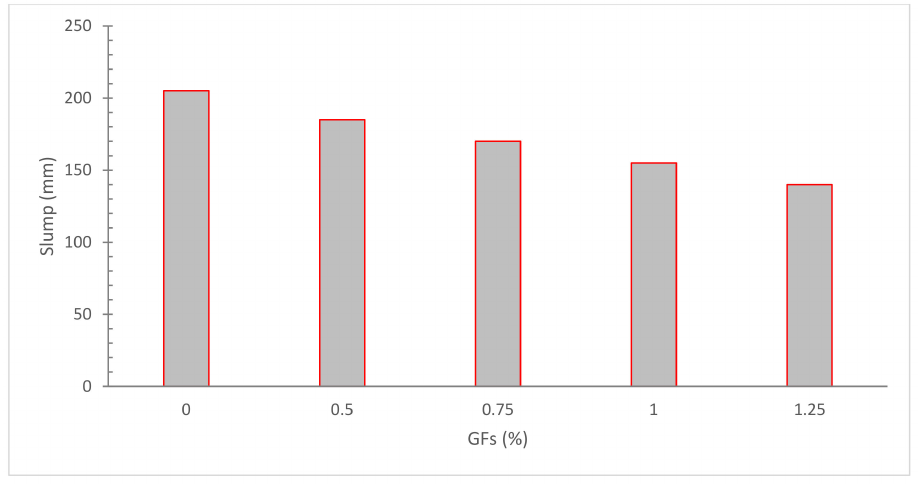
Figure 2. Slump Flow: Data Source